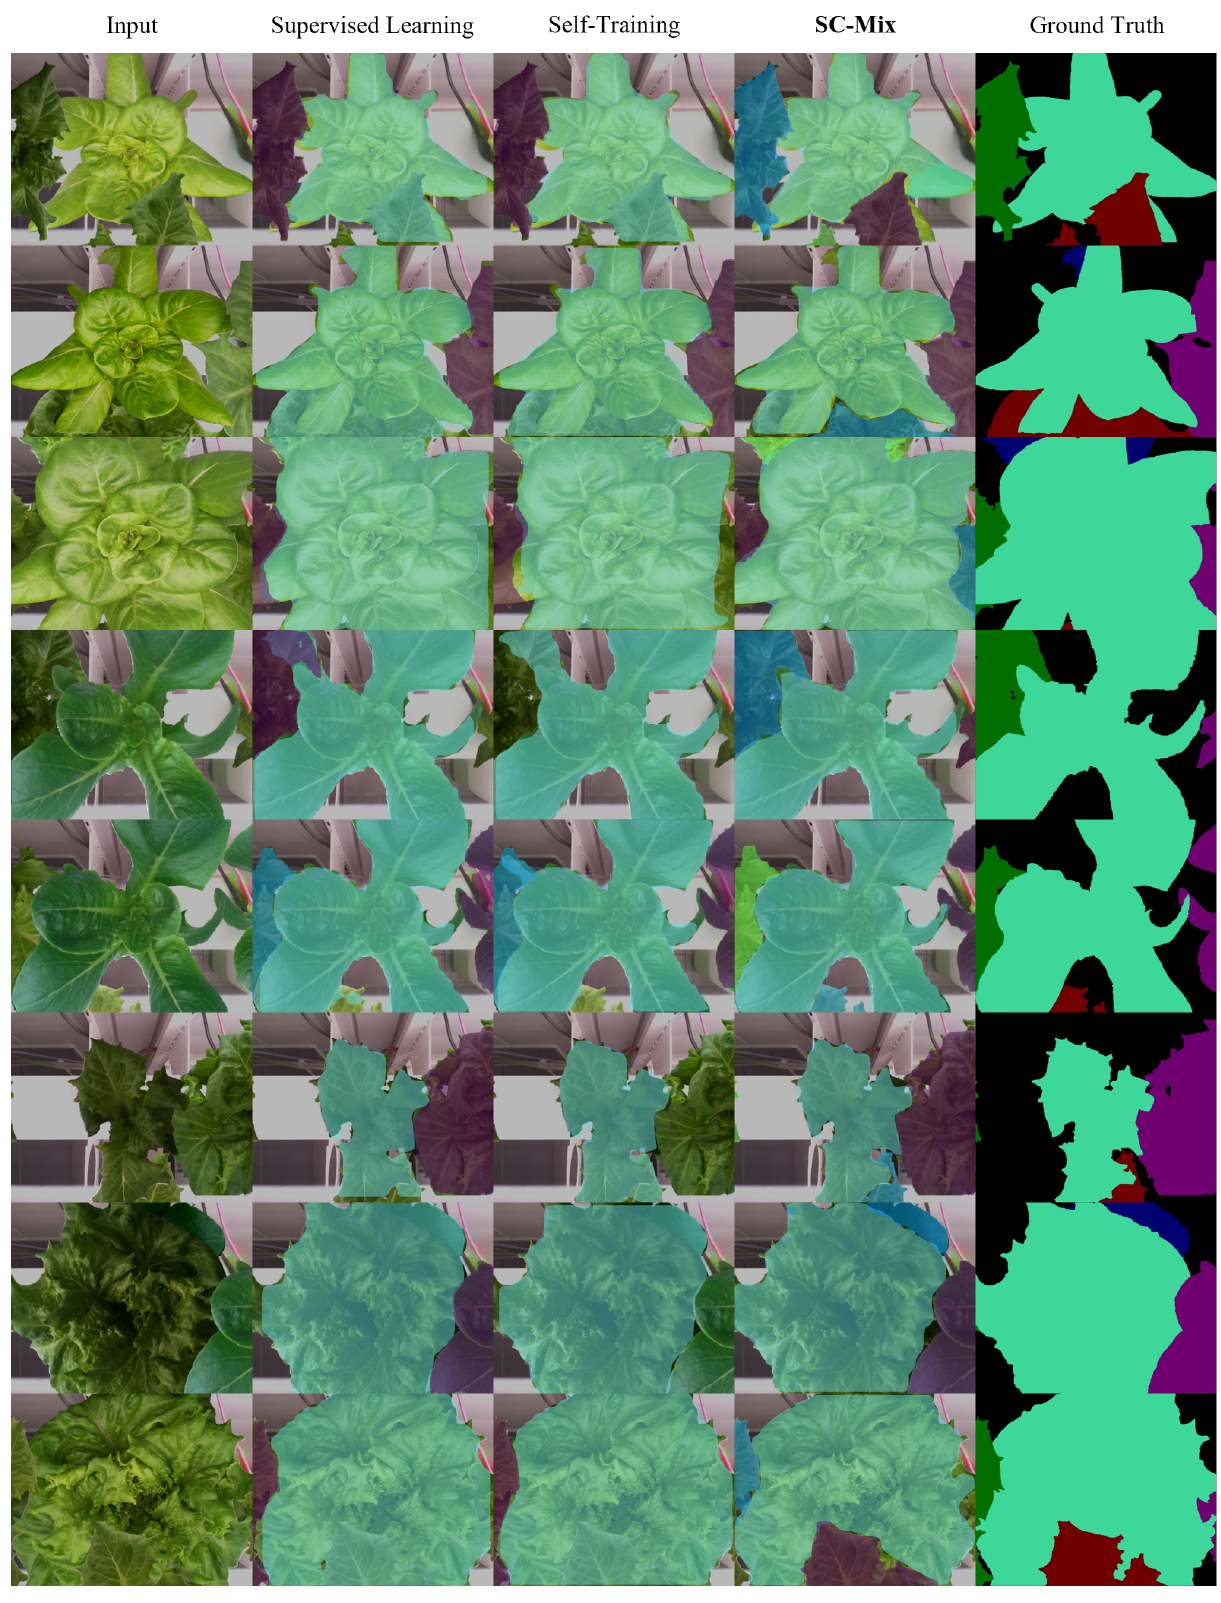
Figure 8. Supervised vs. self-training vs. SC-Mix. Comparison results of synthetic vertical farm images are shown. The model output images include color-coded predictions for different